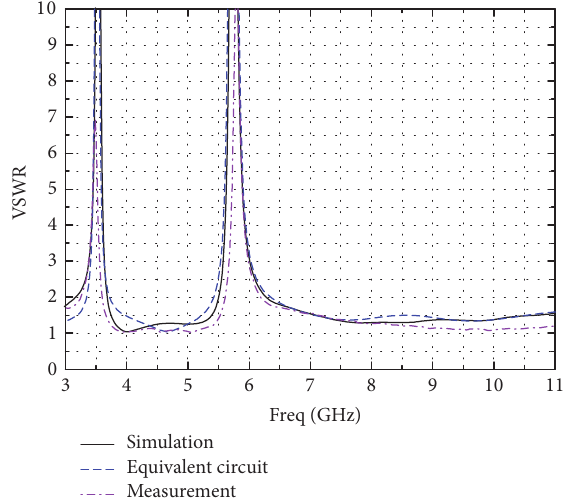
Figure 15: Comparison of simulated and measured VSWR for antenna structure and calculated VSWR for the equivalent circuit.